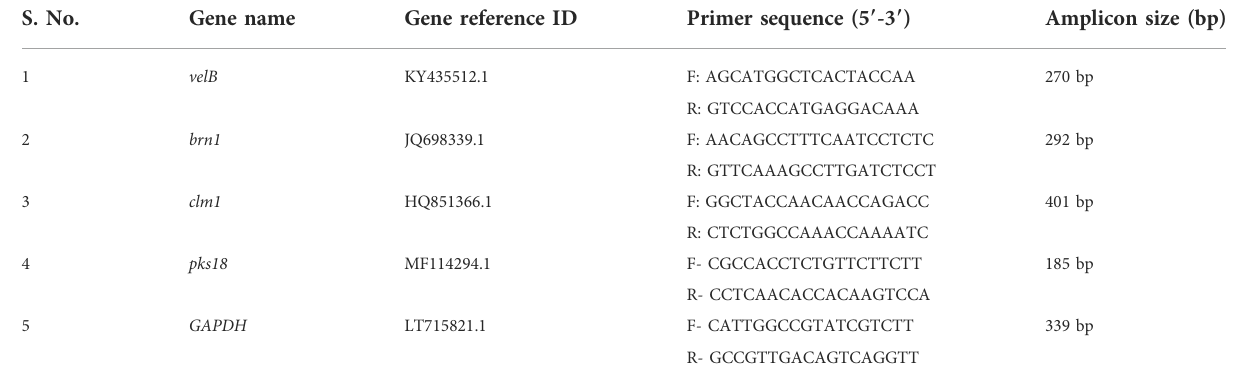
TABLE 1 Gene-speci fi c primers used for qRT-PCR. S.